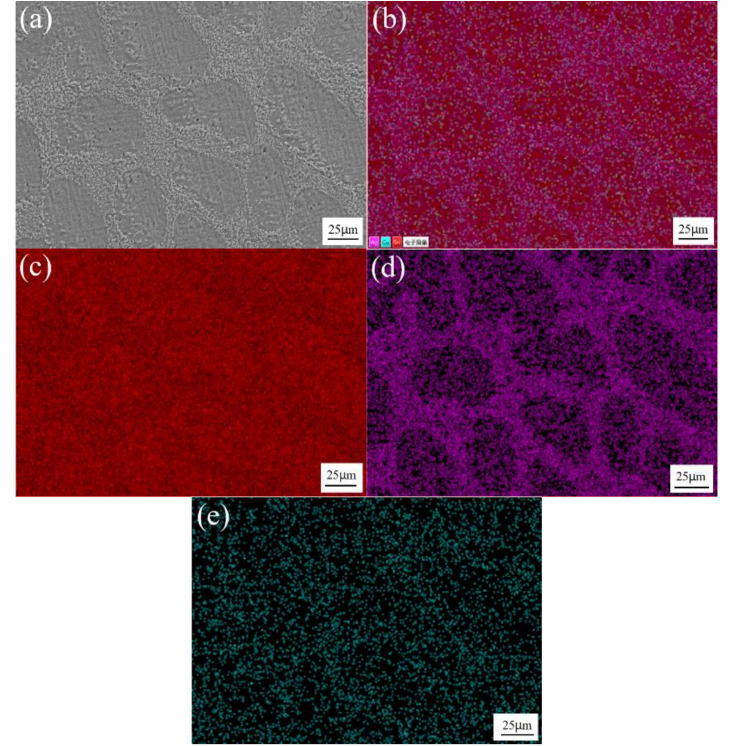
Figure 3. SEM image at 500x of Sn-3.0Ag-0.5Cu ( a ); combined elemental map ( b ); and element distribution maps of Sn ( c ), Ag ( d ), and Cu ( e